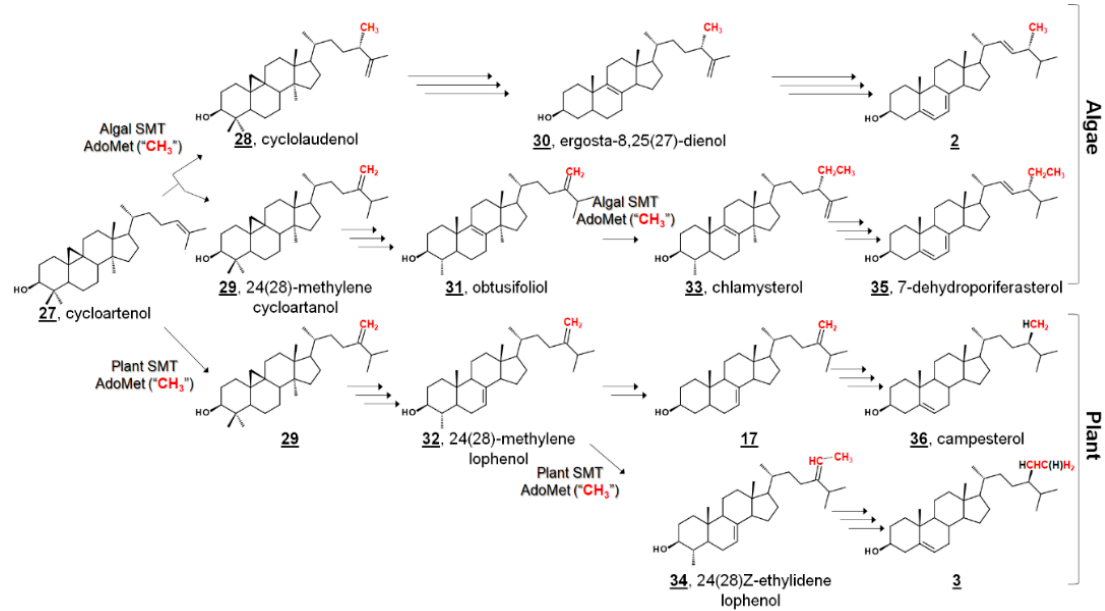
Figure 3. Comparative phytosterol biosynthesis in the photosynthetic lineage from the protosterol cycloartenol 27 . In algae, 24-methyl and 24-ethyl sterols arise from a bifurcation of products of biomethylation by sterol methyltransferase (SMT); In higher plants, they arise from alternate pathways from the intermediate 24(28)-methylene lophenol 30 , which can be methylated again or metabolized to campesterol 36 . Red methyl groups from SMT co-substrate S-adenosyl methionine (AdoMet) are annotated to show hypothetical labeling patterns of ∆ 5 sterols as discussed in [45,50]. An additional 15 algal sterols were reported in [45]. Truncated fungal phytosterol biosynthesis from protosterol lanosterol 12 is illustrated in Figure 2.